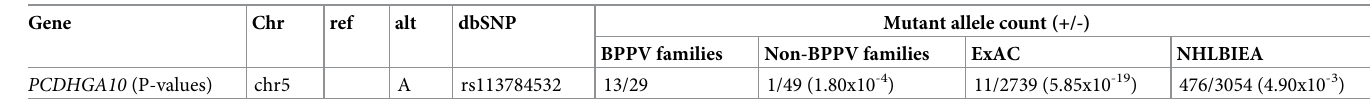
Table 1. Variants observed in BPPV versus non-BPPV families.